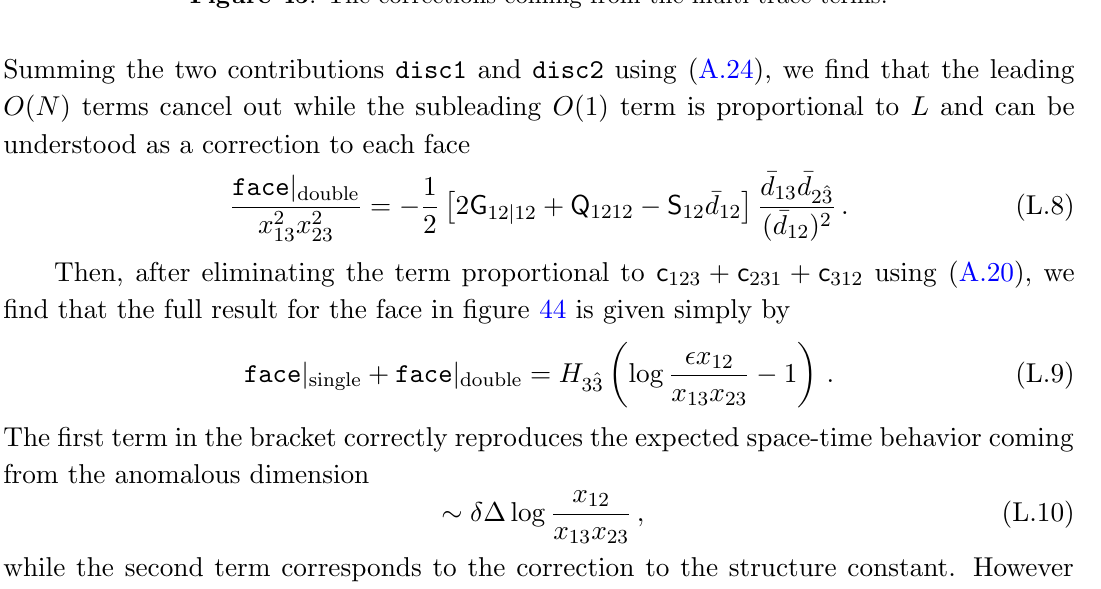
Figure 45 . The corrections coming from the multi-trace